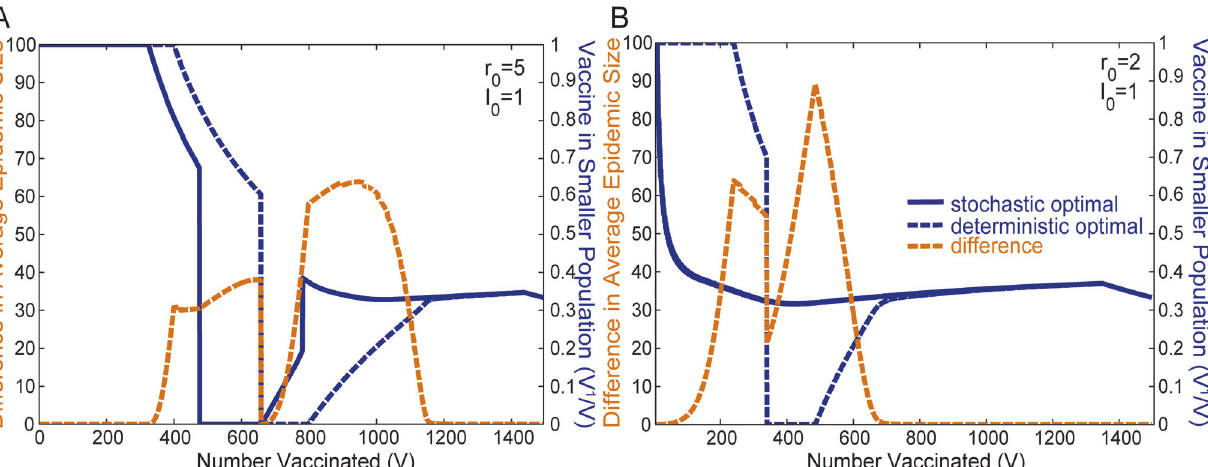
Fig 5. Optimal Protocols Represented as a Fraction of Total Vaccine. The solid blue line shows the optimal fraction of the available vaccine allocated to the smaller population V 1 / V in order to minimize the average stochastic epidemic size h E i . The dashed blue line shows a different optimal allocation that minimizes the deterministic epidemic size E . The right vertical scale applies to these two measurements. The difference in the resultant average epidemic size h E i between the two protocols when applied to the stochastic model is plotted in gold (measured by the left vertical scale). The results are obtained for r 0 = 5 in Figure A, and r 0 = 2 in Figure B, and populations of sizes N 1 = 500 individuals and N 2 = 1000 individuals, both initialized with a single infected individual I 1 ¼ I 2 ¼ 0 0